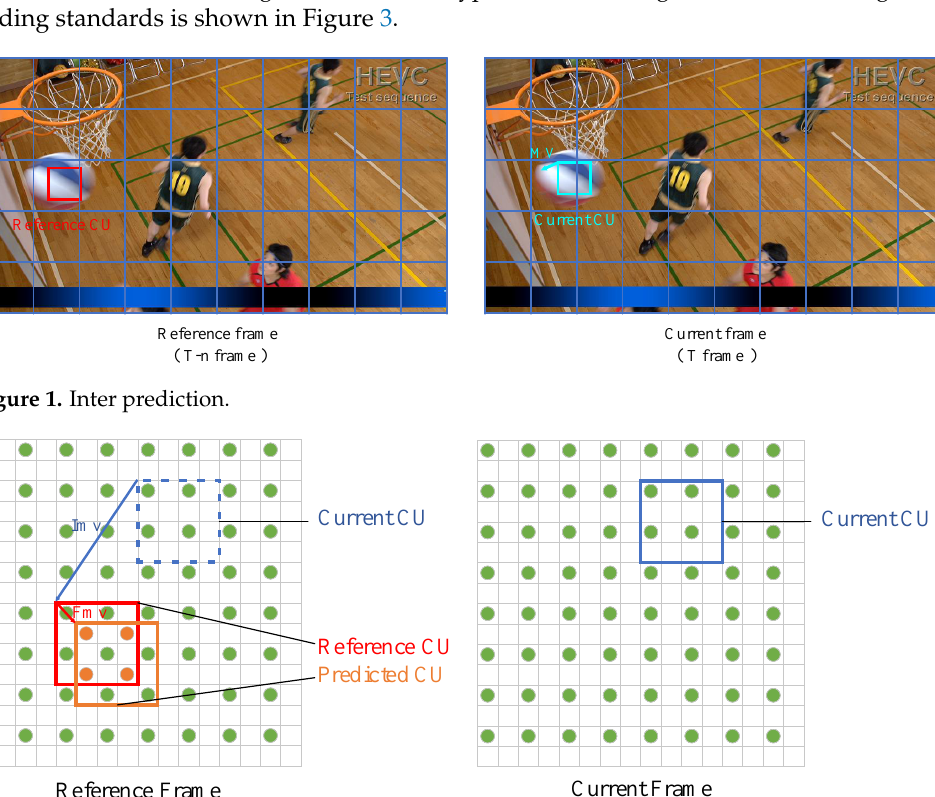
Figure 2. Relationship between the current CU, reference CU, and predicted CU; the block with green dots represents the integer pixel position.